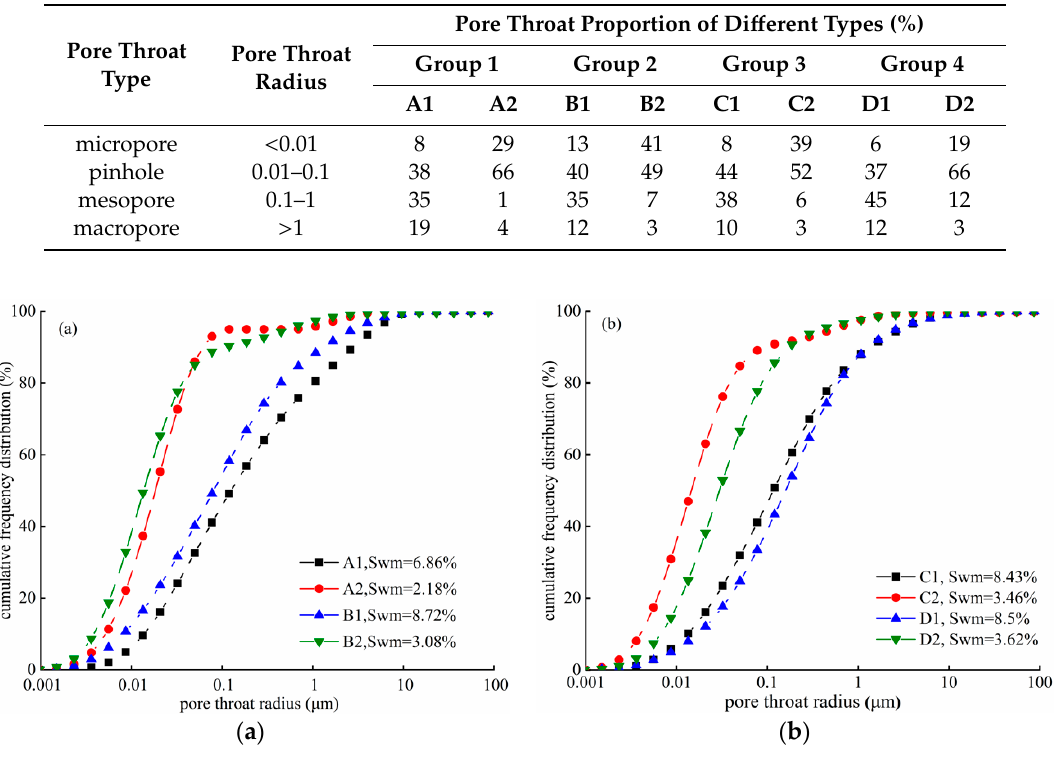
Figure 5. Microscopic pore distribution of tight sandstone cores: ( a ) Core A1, A2, B1 and B2; ( b ) Core C1, C2, D1 and D2.